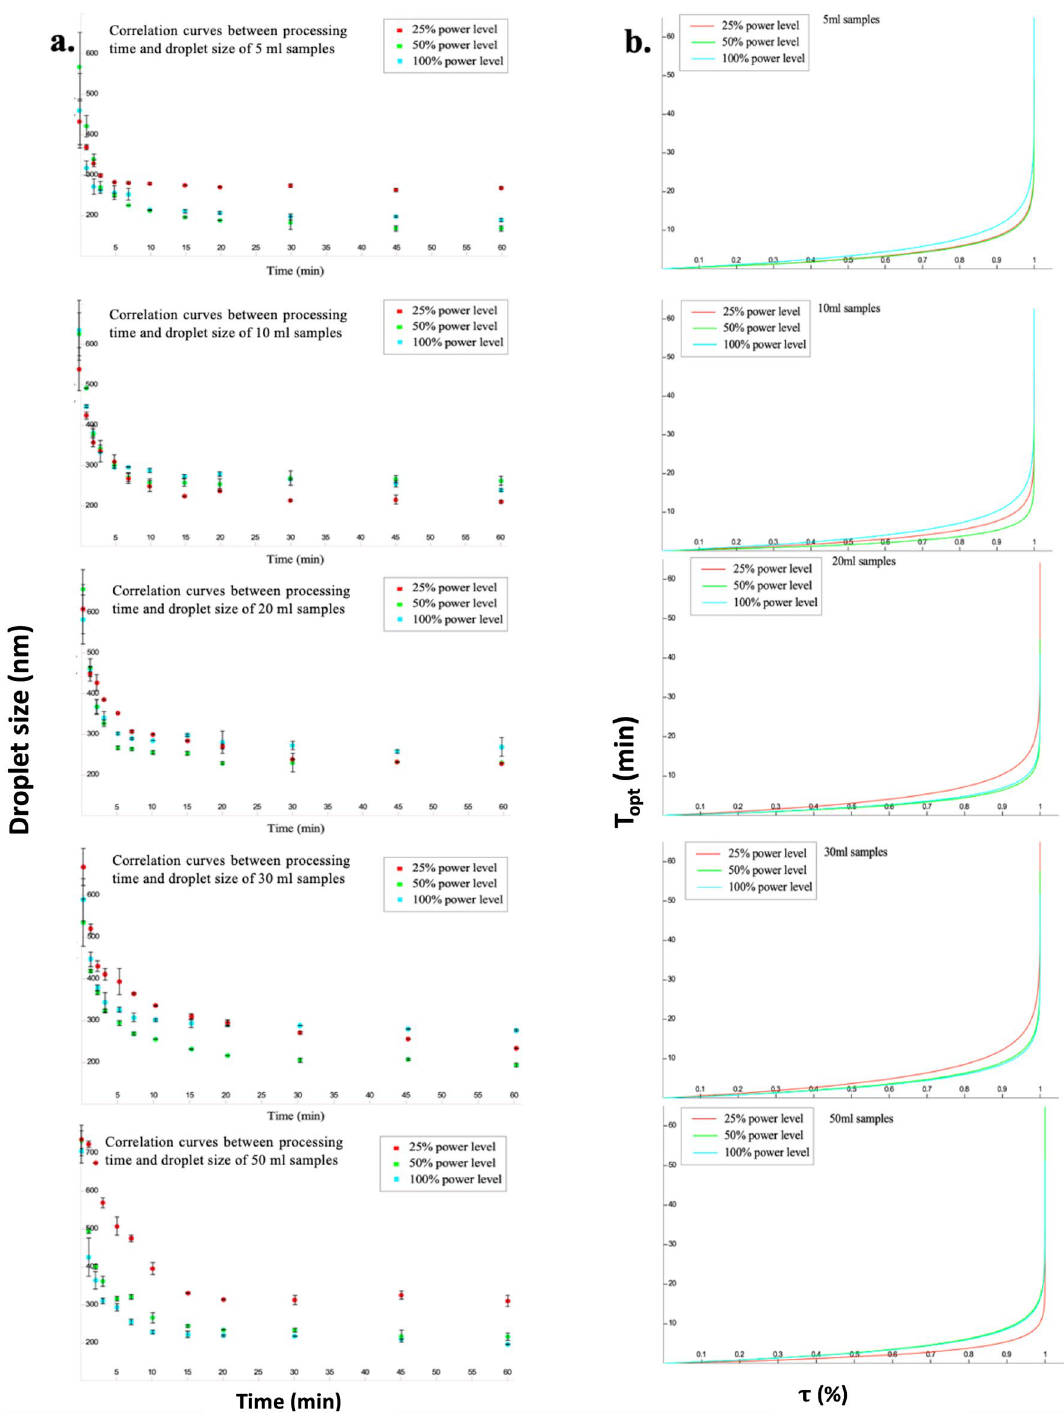
Figure 3. Particle size distribution of emulsion samples with different processing times. (blue shows pre- emulsion before ultrasound processing; red shows emulsion processed for 10 min; yellow shows optimized emulsion processed for 21.74 min; and green shows emulsion processed for 60